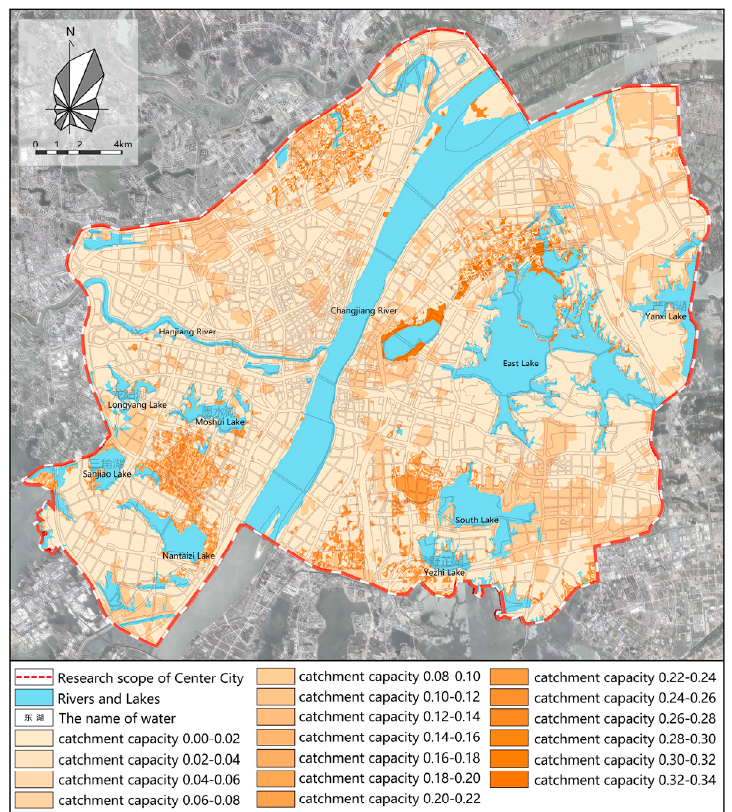
Figure 12. Catchment capacity of downtown Wuhan.